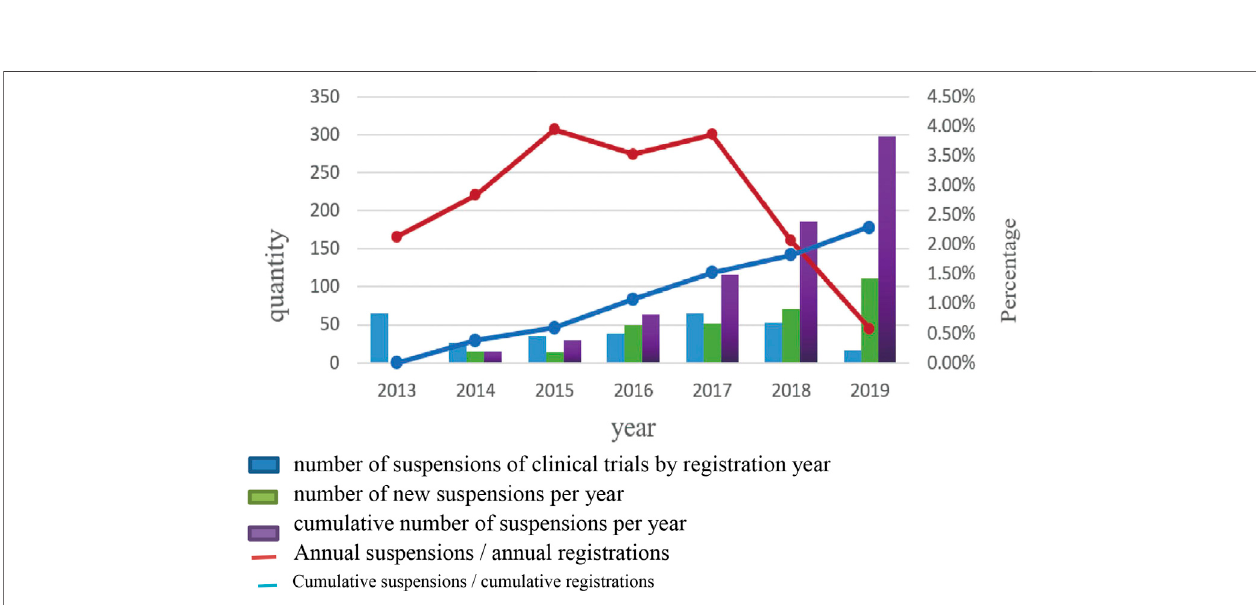
FIGURE 2 | A trend analysis of suspensions of clinical